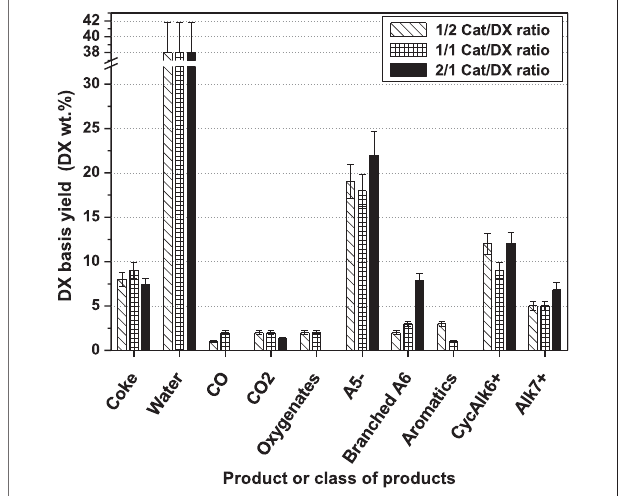
FIGURE 3 | Effect of different Cat/DX ratios on products or a class of products yields calculated based on a DX basis (DX wt%).